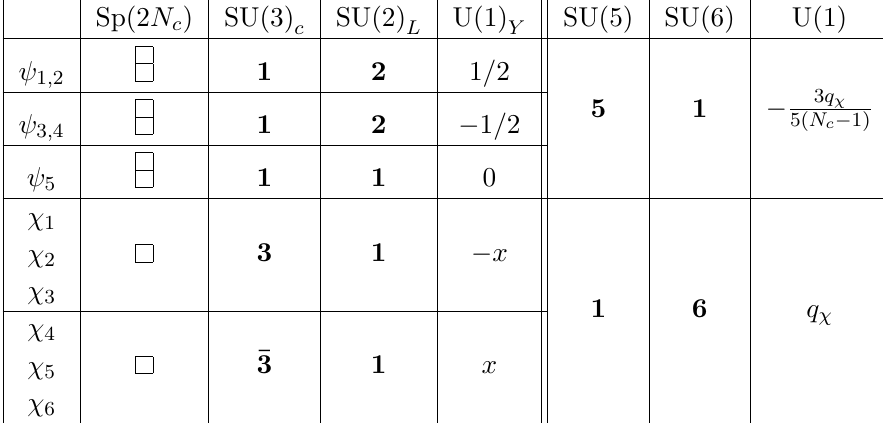
) × SU(3) SU(2) U(1) , and under the global symmetries c c × L × Y